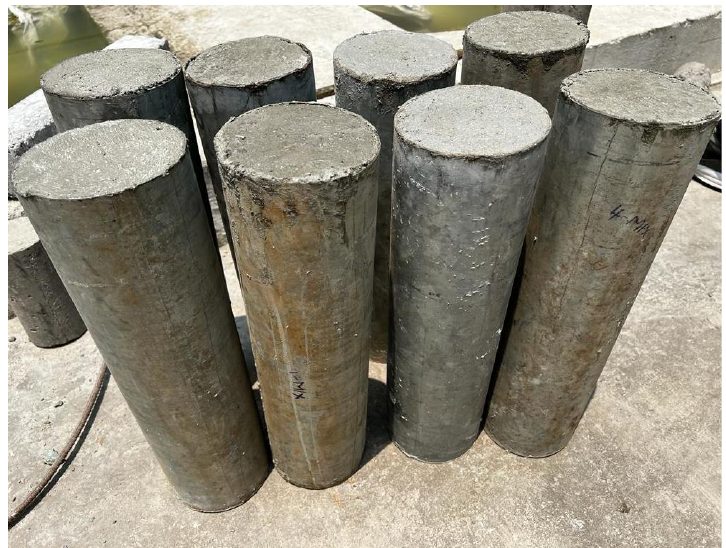
Figure 11. Self-stressed columns.